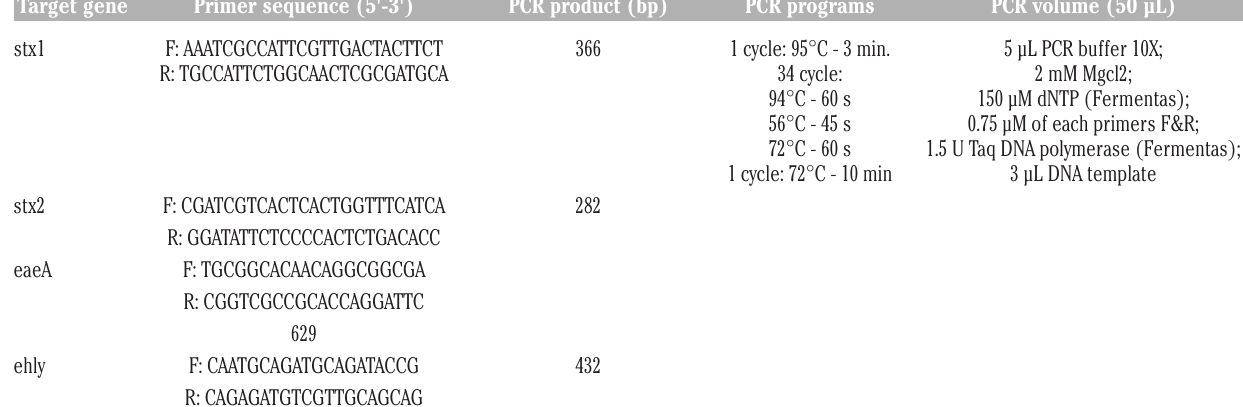
Table 1. Oligonucleotide primers and the PCR program used for amplification of virulence factors in the Escherichia coli isolates of ready to eat foods. 6-8 Target gene